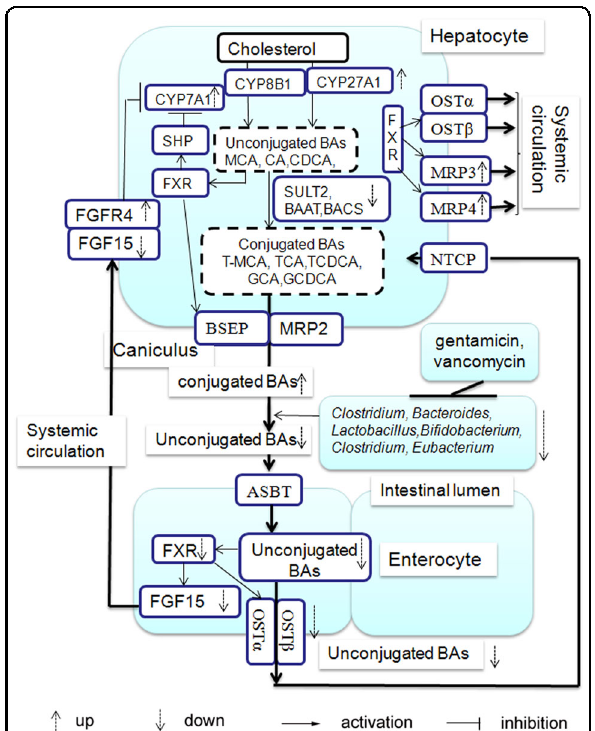
Fig. 6 Schematic depicting the potential in fl uence of antibiotic treatment on bile acid dysmetabolism Antibiotic (gentamicin, which mainly affects Gram-negative bacteria or vancomycin, which mainly inhibits Gram-positive bacteria) administration reduced or depleted the abundance of bile acid (BA)-biotransforming bacteria. The main bacterial genera of the gut bacteria involved in BA metabolism included Bacteroides , Clostridium, Lactobacillus, Eubacterium , and Bi fi dobacterium , which mediate BA deconjugation and oxidation; the epimerization of hydroxyl groups at C3, C7 and C12; 7-dehydroxylation; and desulfation. The depletion of BA- biotransforming bacteria caused BA dysmetabolism with an alteration of the BA composition, re fl ected by the increased proportion of conjugated primary BAs and the decreased proportion of unconjugated BAs. In the terminal ileum, the low levels of unconjugated BA (including FXR agonist CDCA) could not activate the FXR and correspondingly reduced the production of FGF19/15, which resulted in increased BA synthesis in the liver by upregulating the enzymes CYP7A1, CYP8B1, and